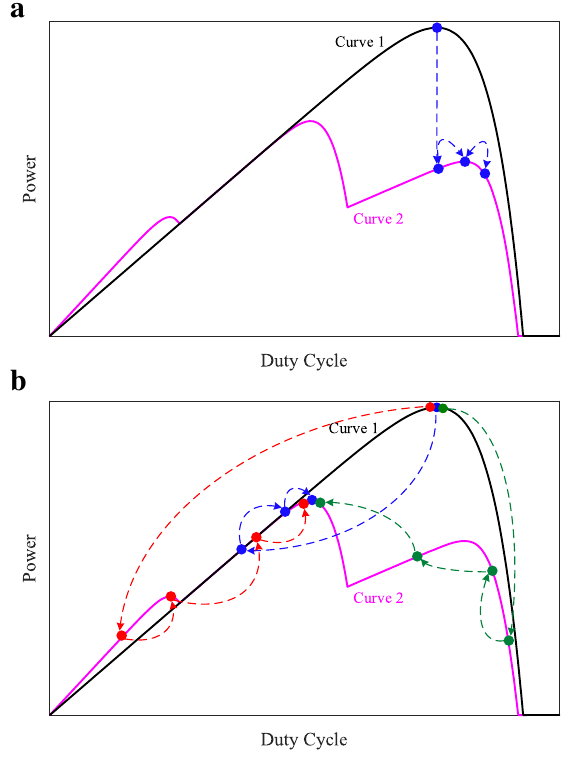
Fig. 8 P - D characteristics for MPP tracking under partially shaded conditions. a P&O and ( b ) the proposed